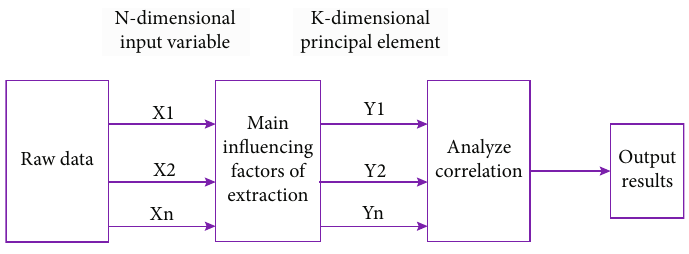
Figure 1: Design of tax forecasting